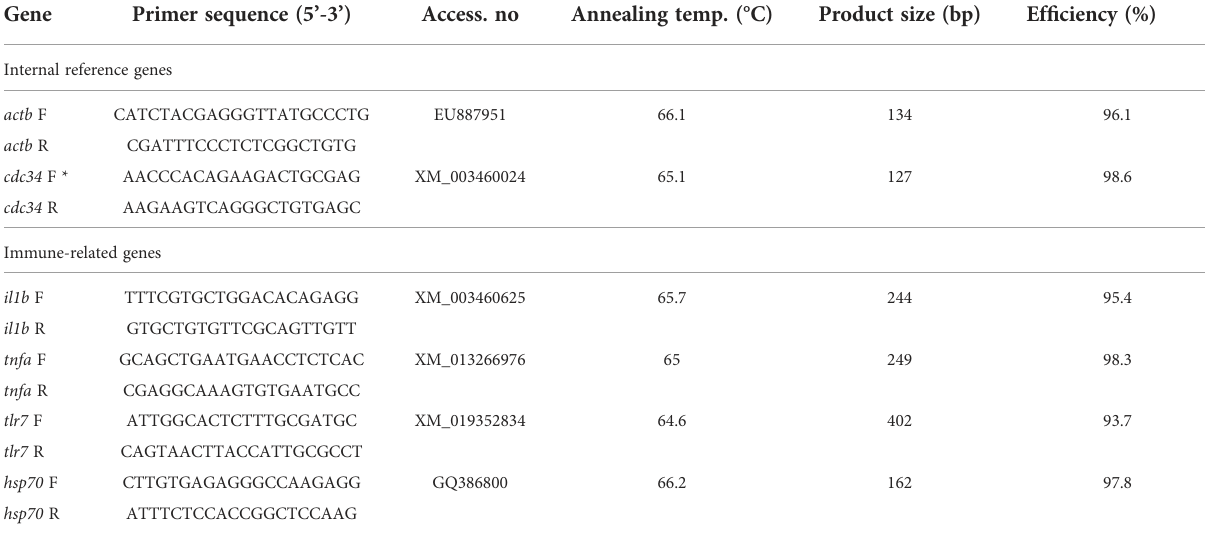
TABLE 3 Primers Sequences and qRT-PCR conditions.